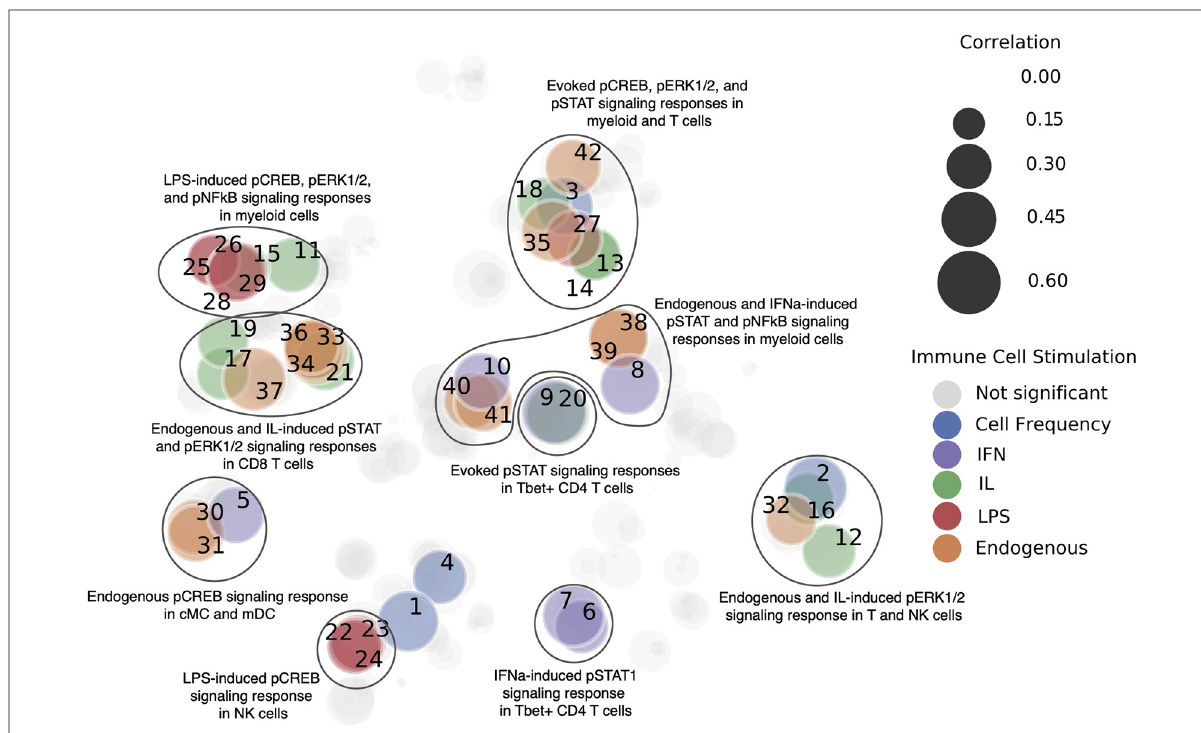
FIGURE 6 Immune features that are predictable from PSFs. Immune features were clustered by immune cell stimulation (designated by color), and models were trained to predict these features. Signi fi cant immune characteristics ( p <0.05 after correction via Benjamini-Hochberg false discovery rate) as predicted from the 79 original PSFs are colored. Prediction quality measured via Spearman correlation is represented by the size of the nodes. Each immune feature is labeled with a number, which maps to Supplementary Table S2 . This analysis indicated that stress factors can predict components of the immune system, which paves the way for an integrative immune and stress model of